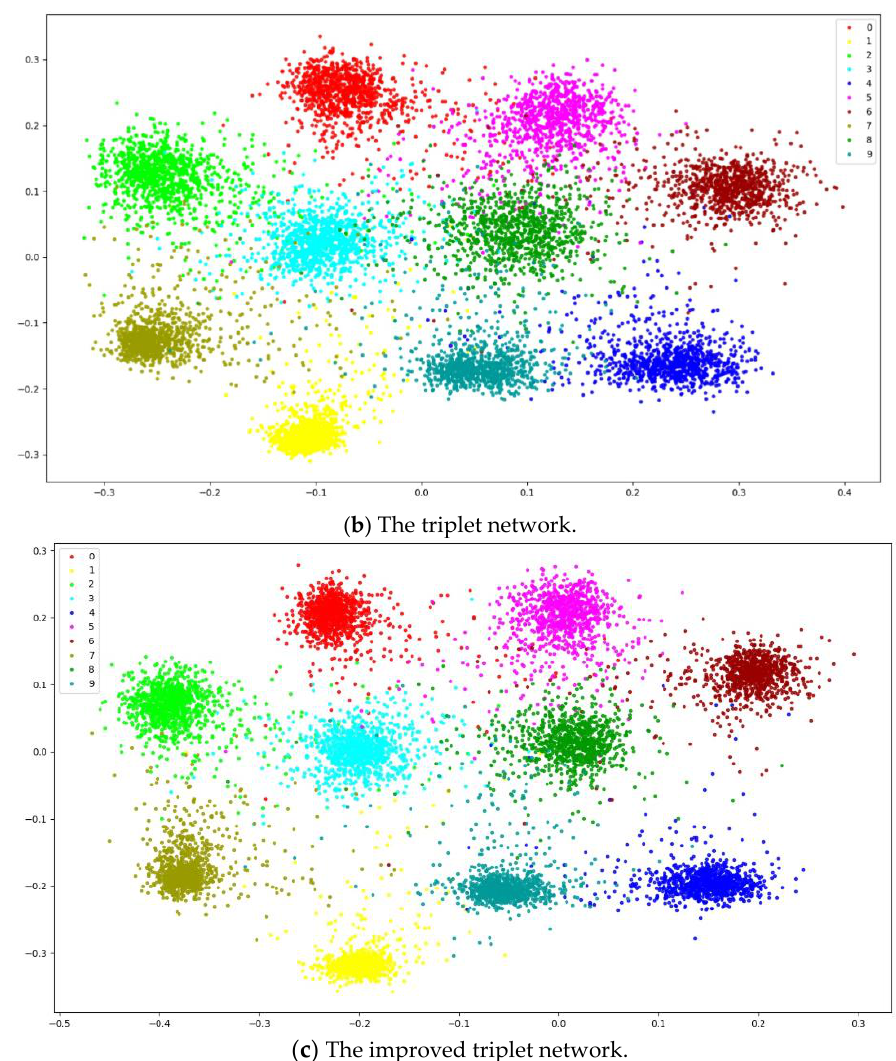
Figure 10. We project these feature vectors of the MNIST test dataset onto a two-dimensional space coordinate system, according to their Euclidean